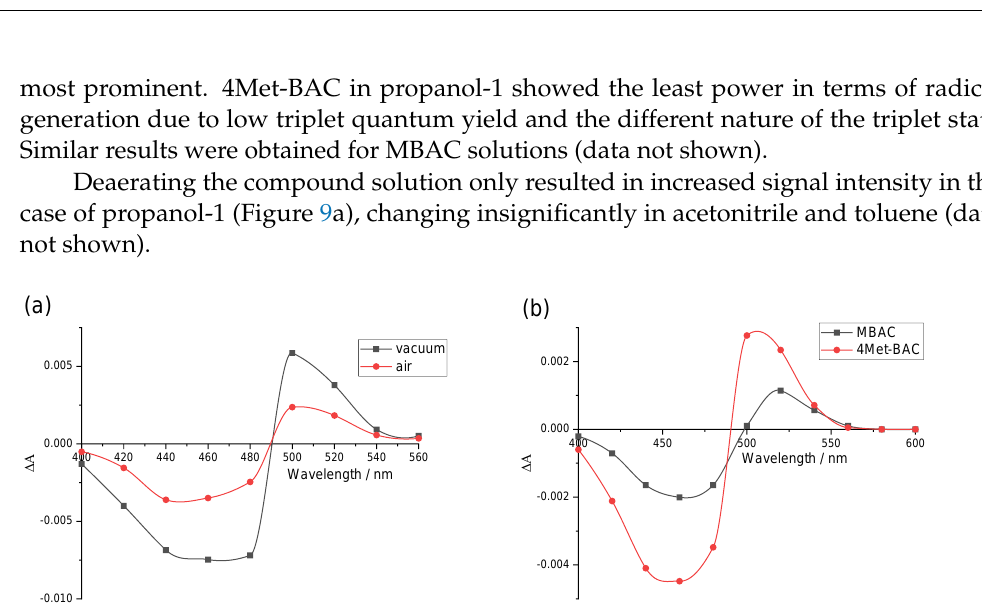
Figure 9. ( a ) Differential transient absorption spectra of 4Met-BAC (7 × 10 − 7 M) in propanol-1 100 ms after flash. ( b ) Differential transient absorption spectra of MBAC (1 × 10 − 6 M) and 4Met-BAC (1 × 10 − 6 M) in air-equilibrated propanol-1 50 ms after flash.